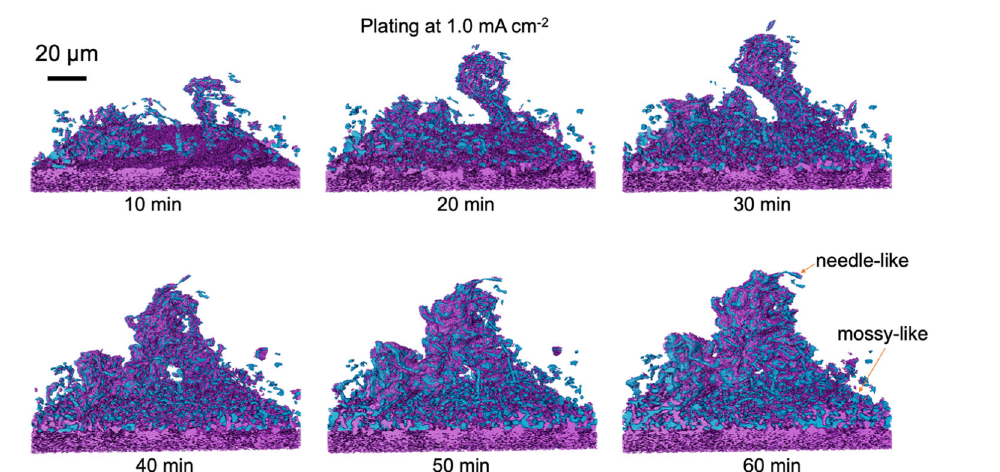
Fig.4|EvolutionofLimicrostructureformedbytheintegrationofaLidendrite and mossy structures. Renderings are extracted from tomograms taken during platingat1.0mAcm – 2 for10, 20,30,40, 50,and 60min.Liisshowninblue, purple